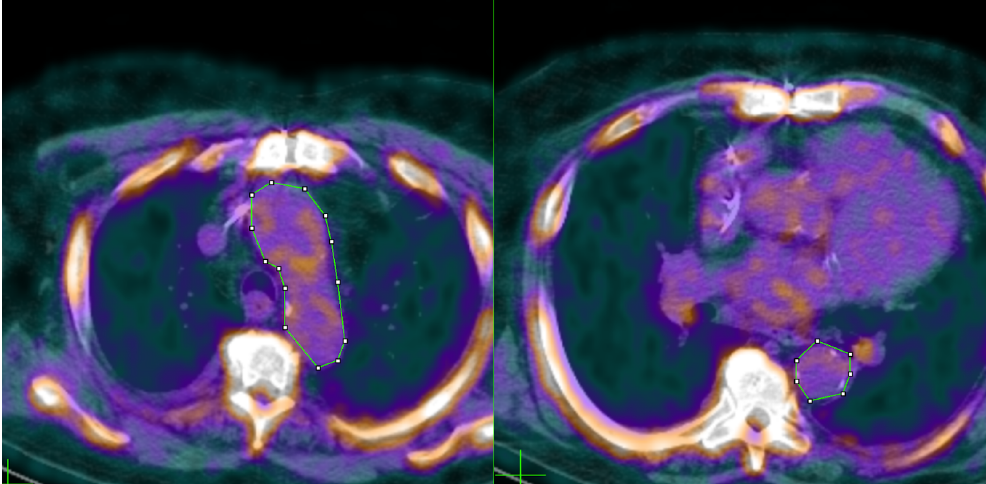
Figure 5. Fused PET/CT images showing example segmentations of the aorta. ROIs were manually selected on axial slices of the thorax. Colored heat maps of the PET scan served as a visual indicator of 18F-NaF tracer uptake, which was overlaid on structural anatomical information from the CT scan. For each ROI, SUVmean was recorded in Fiji Image Viewer. Left : A manually selected ROI outlined in green is shown encompassing the aortic arch. Right : An ROI taken from the thoracic aorta.